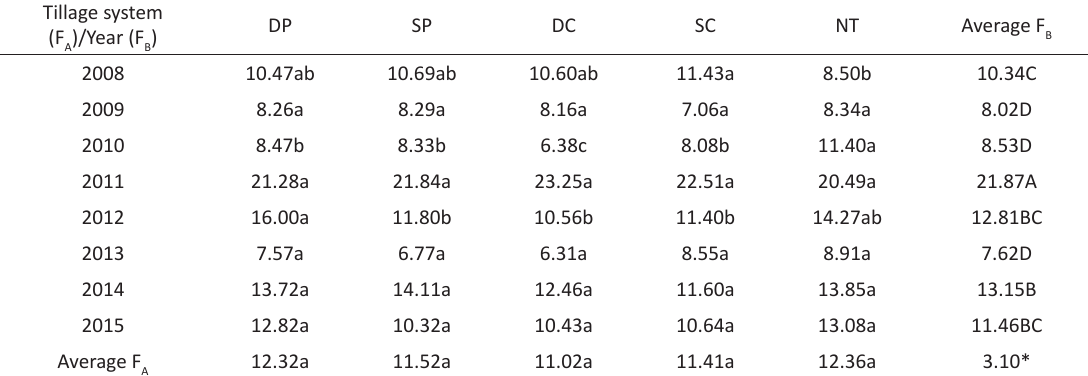
Table 8. The impact of the tillage systems on the total dry biomass of the maize canopy (Mg ha -1 ) Tillage system (F